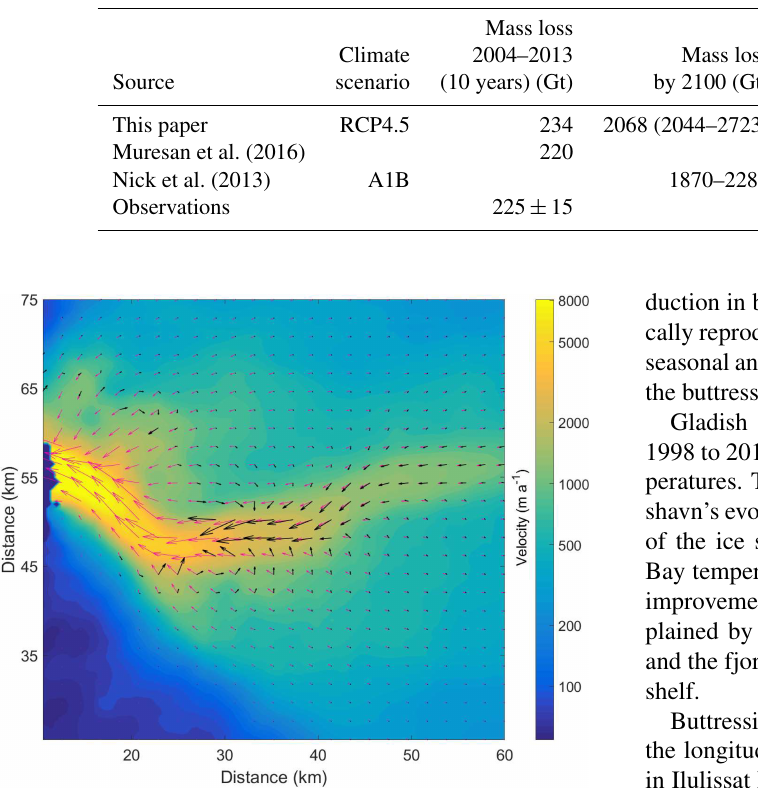
Table 1. Estimates of glacier mass loss and grounding line retreat from different sources.